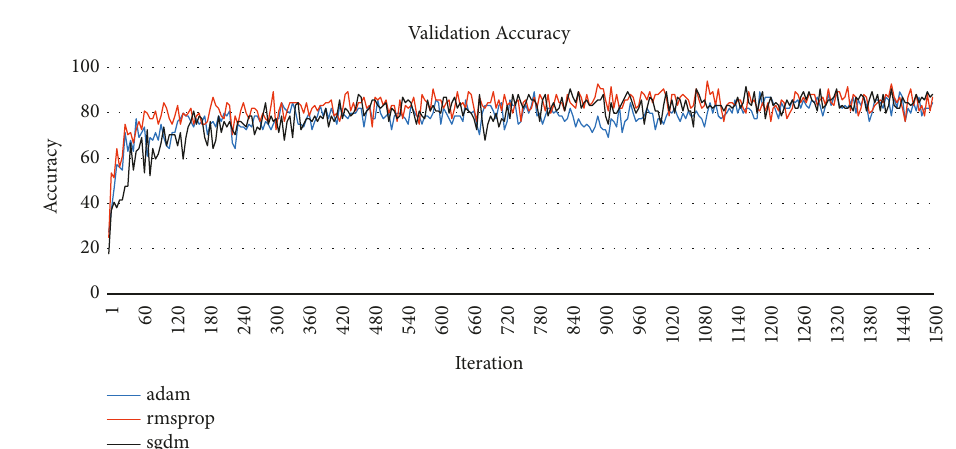
Figure 7: Validation accuracy of different solver models when the initial learning rate is